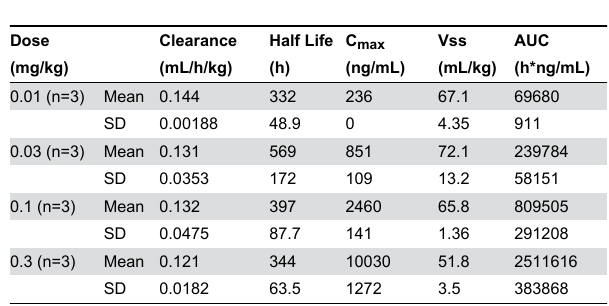
Table 2. Summary of pharmacokinetic properties of NKTT120 in cynomolgus macaques.